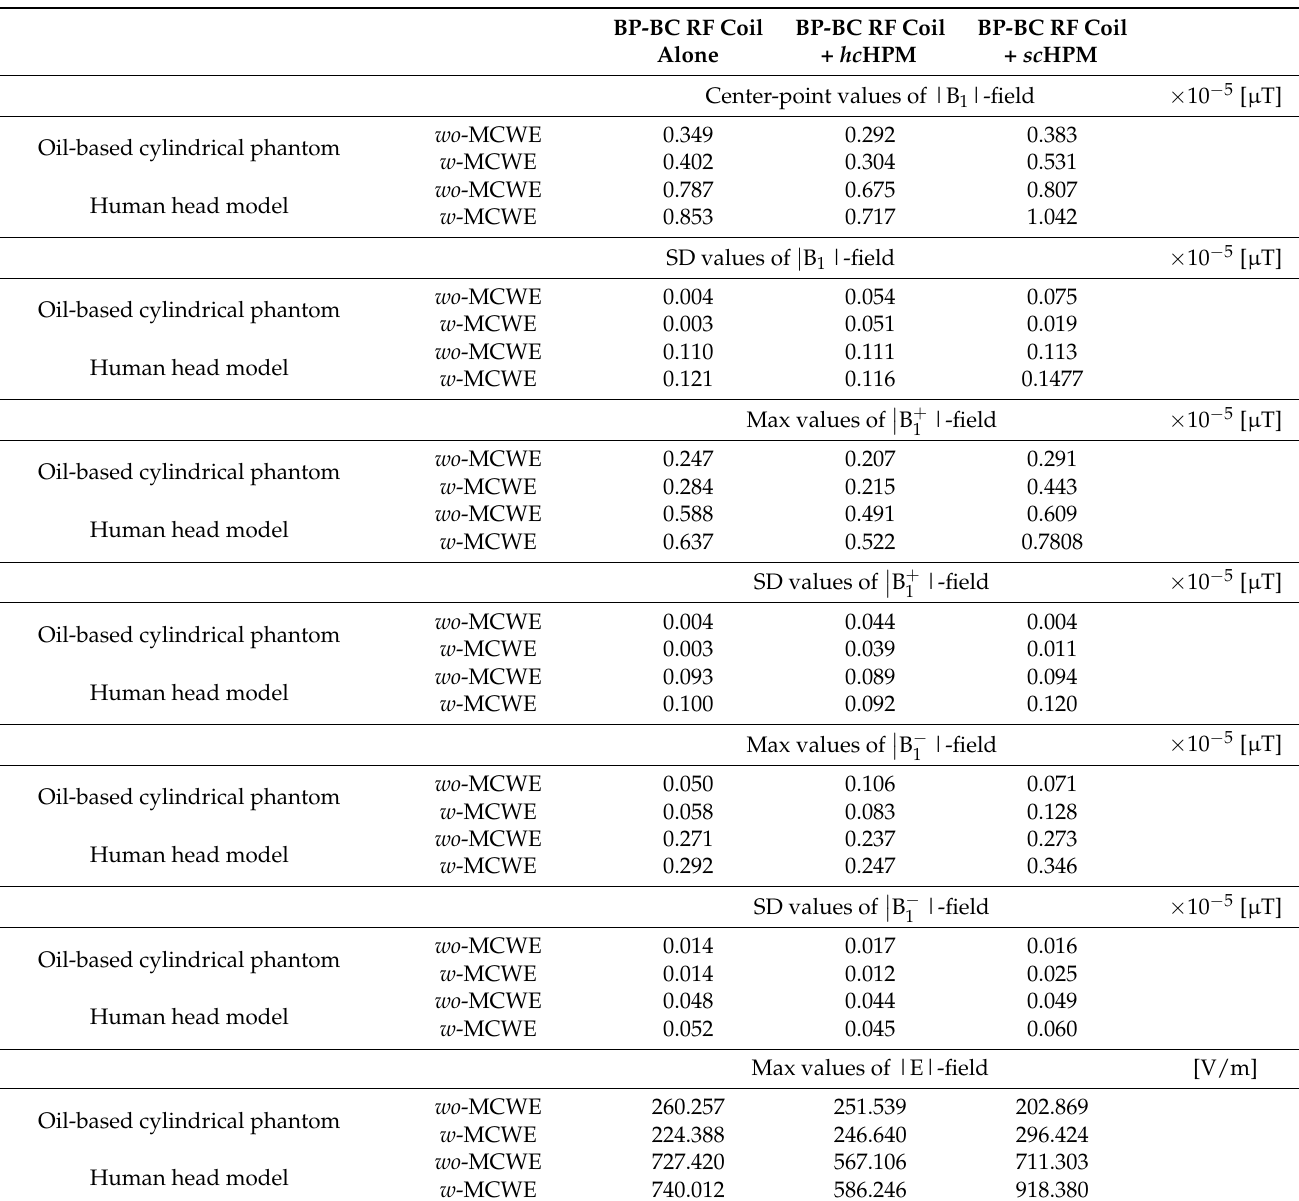
Table 1. The maximum values of EM-field simulation results (|B 1 |-, |B + using oil-based cylindrical phantom and human head model.